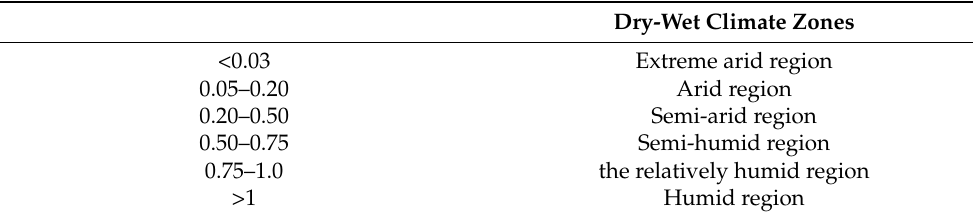
Table 1. Grades of wetness index based on Chinese climate classification